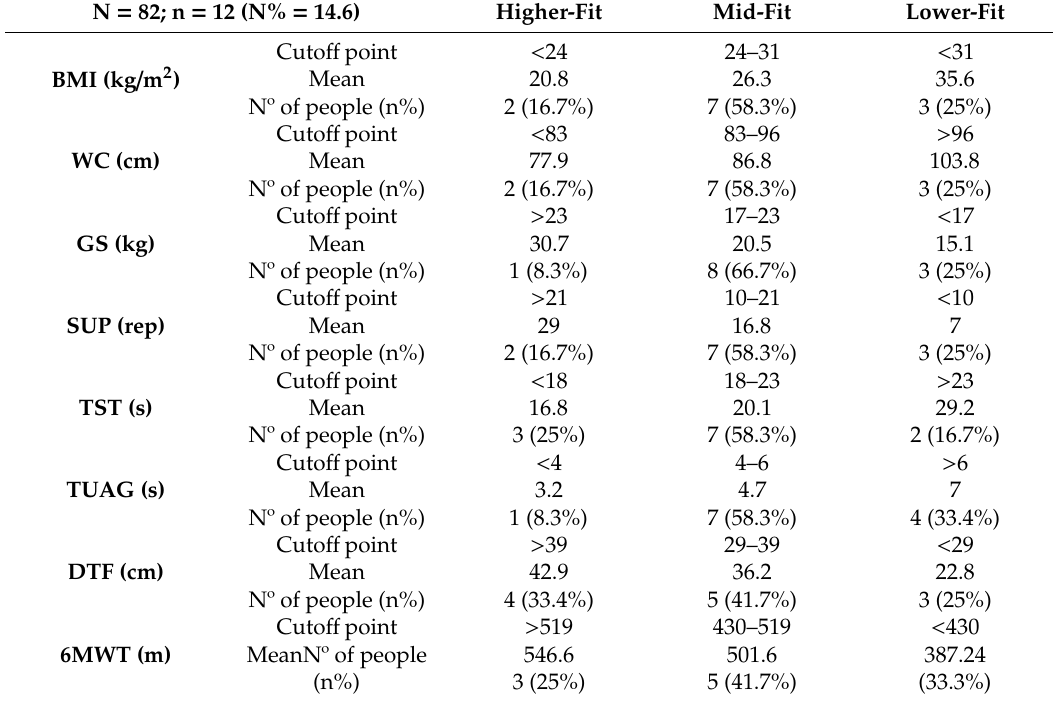
Table 6. Older women ( > 50 years old) results for each variable categorized in 3 PF levels. N = 82; n = 12 (N% =